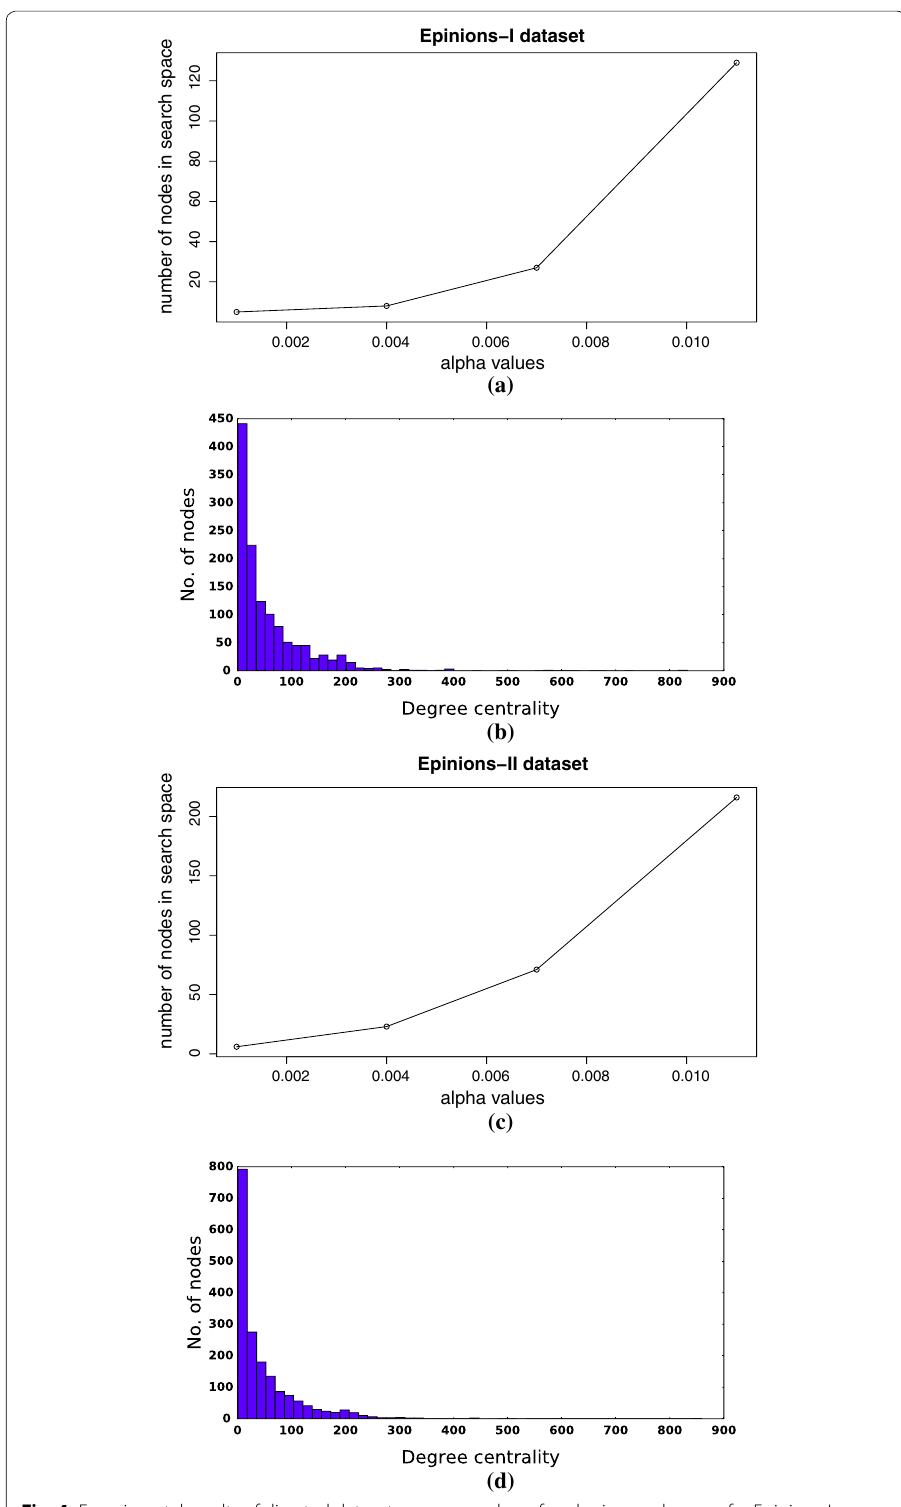
Fig. 4 Experimental results of directed datasets. a α vs number of nodes in search space for Epinions-I dataset. b Degree centrality distribution of Epinions-I dataset. c α vs number of nodes in search space for Epinions-II dataset. d Degree centrality distribution of Epinions-II